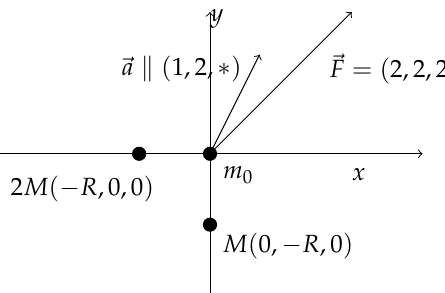
Figure 1. Simple example for the check of Assumption